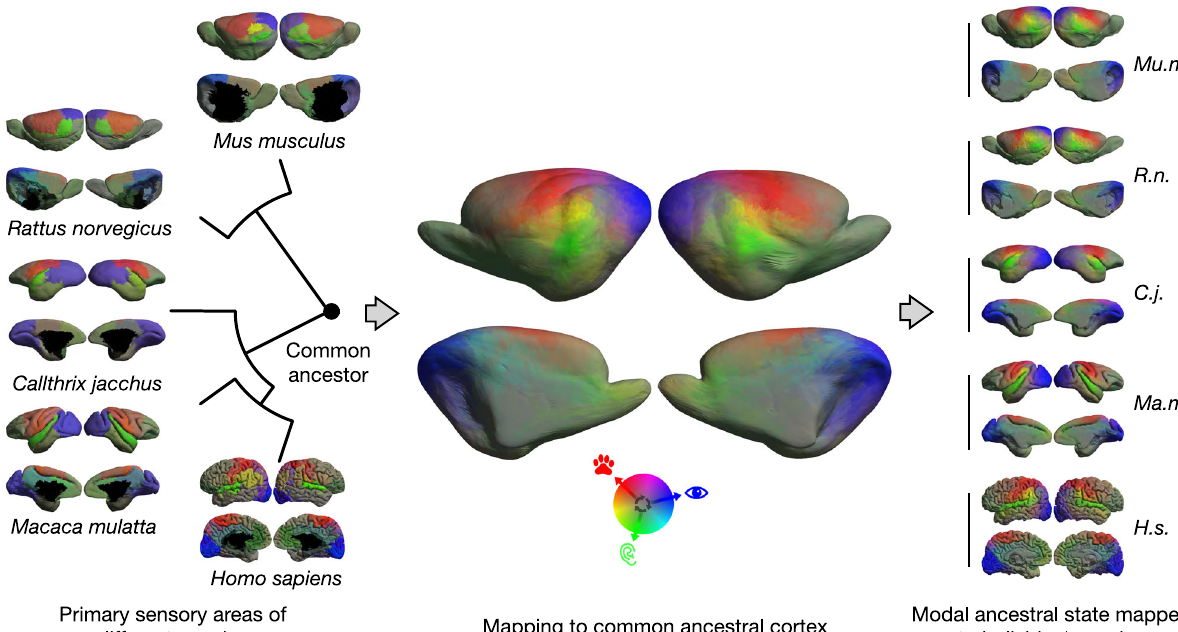
Fig. 5 | The ancestral state of regional functional modal specialisation of cor- tical areas. Cortical surface shape alignment across species and to common ancestors allows for the estimation of the spatial distribution of primary sensory areas (vision: blue, auditory: green, somatosensory: red) in the ancestral state of primates and rodents. The ancestral state can be mapped to all surfaces in the